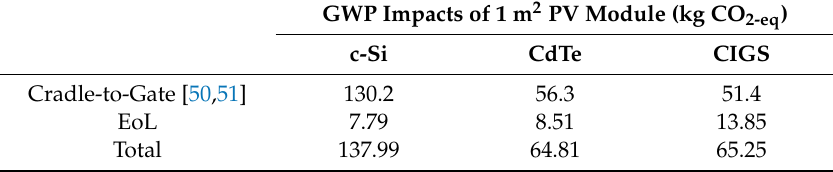
Table 5. The comparison of associated CO 2-eq emissions of entire life cycle of di ff erent PV technologies. The contribution of transportation to the total GWP impacts are found to be ~3%, 4%, and 9% for c-Si, CdTe, and CIGS PVs,